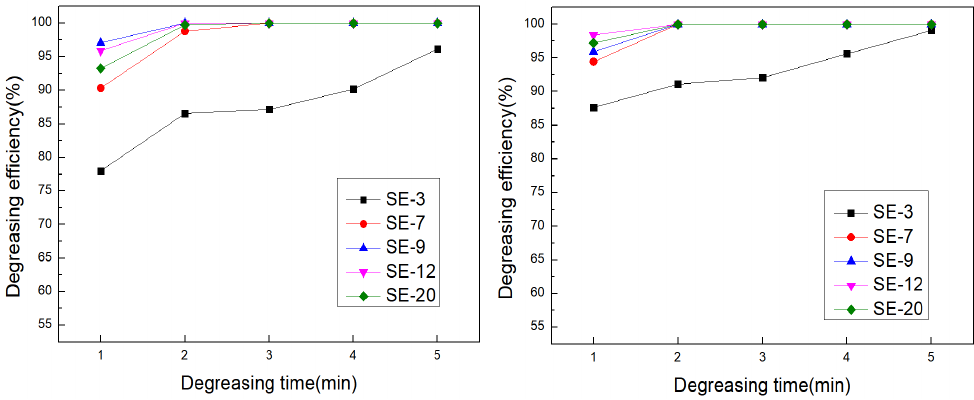
Figure 2. Degreasing efficiency over time at degreasing temperatures of 50 °C ( left ) and 60 °C ( right ).